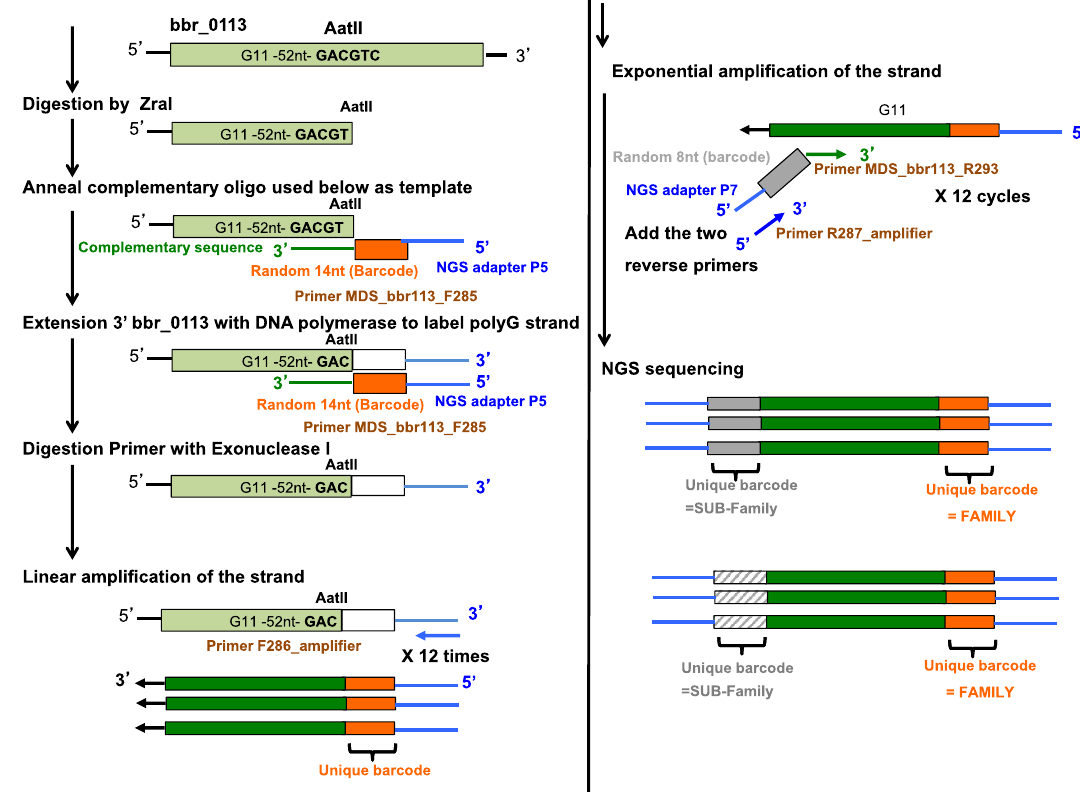
Figure 3. Maximum Depth Sequencing (MDS). The chromosomal DNA strand containing the sequence of interest, such as G11 of bbr_0113, is digested 3’ by a restriction enzyme (AatII). A synthetic oligonucleotide containing 5’ the NGS adapter P5 sequence (blue line), 14nt random sequence “family tag” (orange rectangle) and a sequence (green line) being reverse and complementary to the sequence of the newly produced 3’end of the chromosome strand, is used as template to incorporate the family tag and adapter sequence 3’ to the sequence of interest. Un-incorporated oligos are digested by Exonuclease I. Then, 12 cycles of linear amplification are performed with a specific “primer amplifier” complementary to the newly neo-synthesized DNA 3’end. Corresponding products are then used as template in exponential amplification involving the addition of a second primer. It contains 5’ the NGS adapter P7 sequence (in blue), an 8nt random sequence but can be facultative (in grey rectangle), and a sequence (in green) being reverse and complementary to a